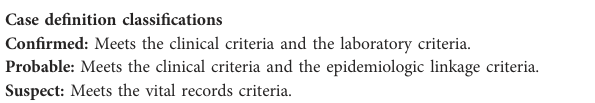
TABLE 1 Council of state and territorial epidemiologists/CDC surveillance case de fi nition for multisystem in fl ammatory syndrome (MIS-C) in children associated with SARS-CoV-2 infection – June 2022